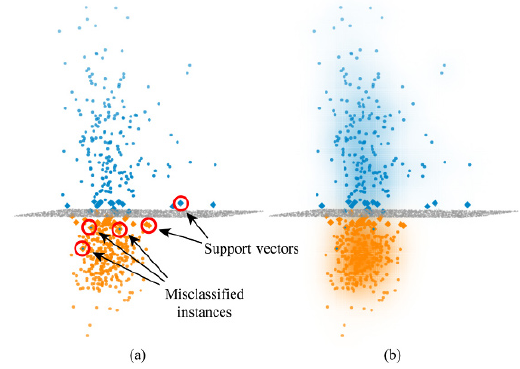
Fig. 6 Examples of projections: (a) visual encoding applied to data points, (b) a density map composition.